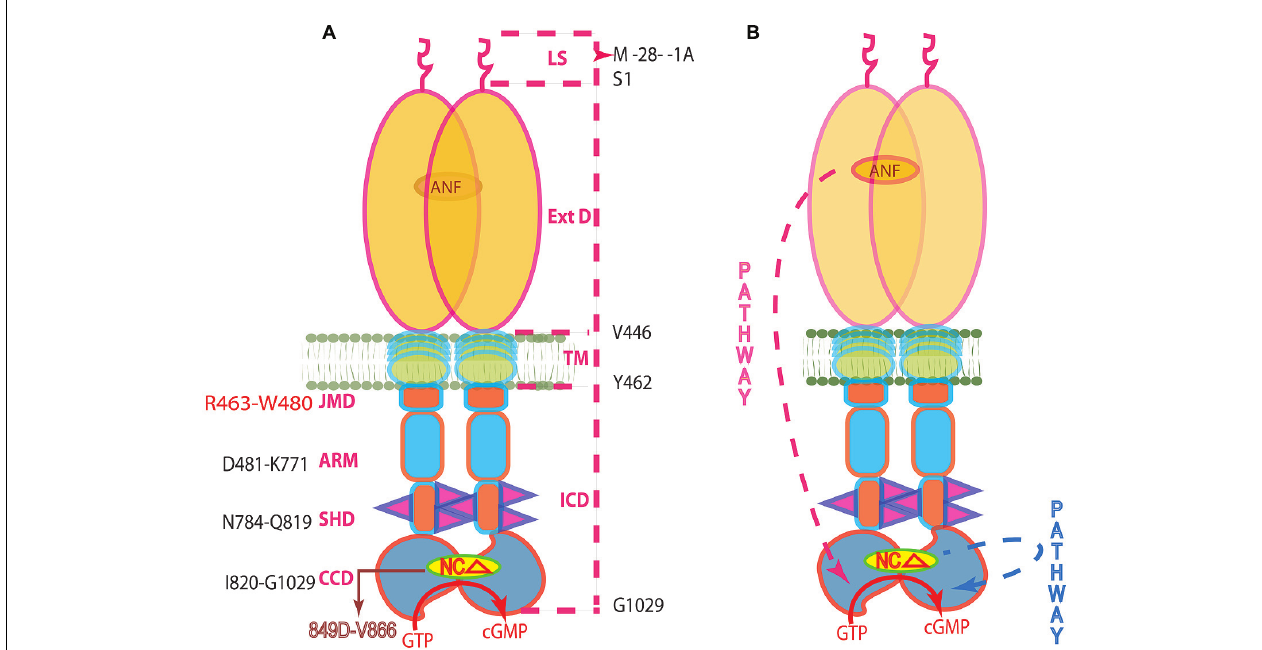
FIGURE 3 | (A) Topography of ANF-RGC. The dashed lines on the right show the boundaries of: LS, leader sequence; ExtD, extracellular domain;TM, transmembrane domain; ICD, intracellular domain.The functional domains in ICD, their names and the aa constituting their boundaries are indicated at the left: JMD, juxtamembrane domain; ARM, the ATP regulated module; SHD-signaling helix domain; CCD-core catalytic domain.The site targeted by